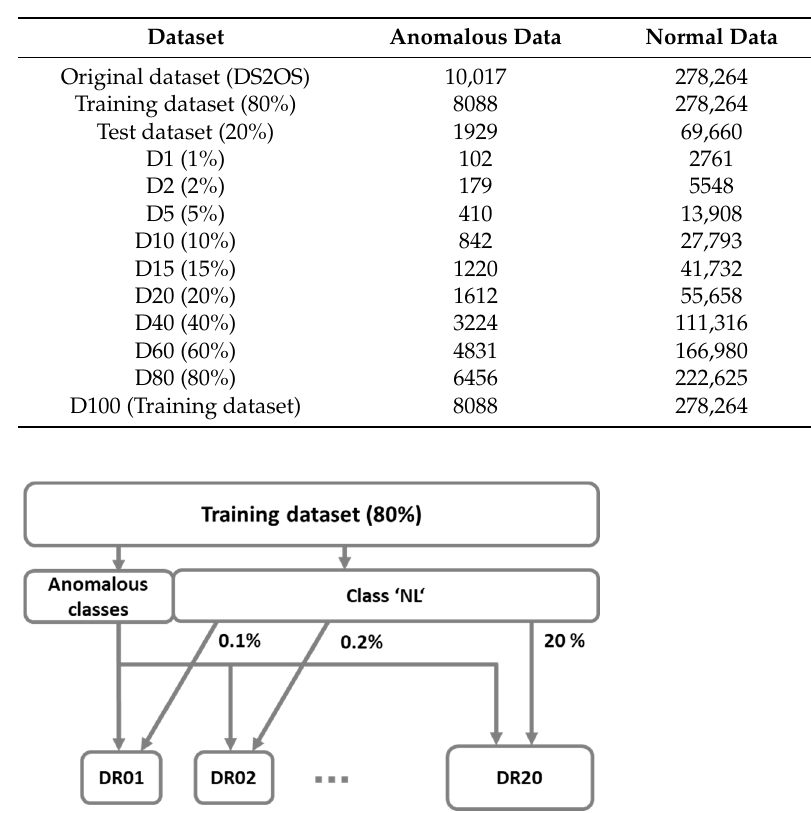
Table 1. Random distribution of DS2OS dataset to training/test dataset and subsets of training